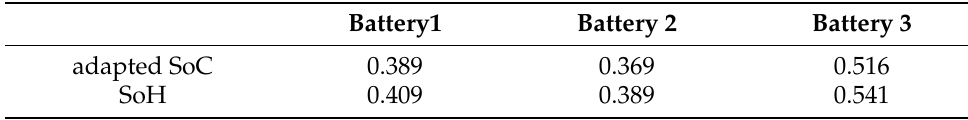
Table 20. Capacity fade of the control strategies for Case 2.